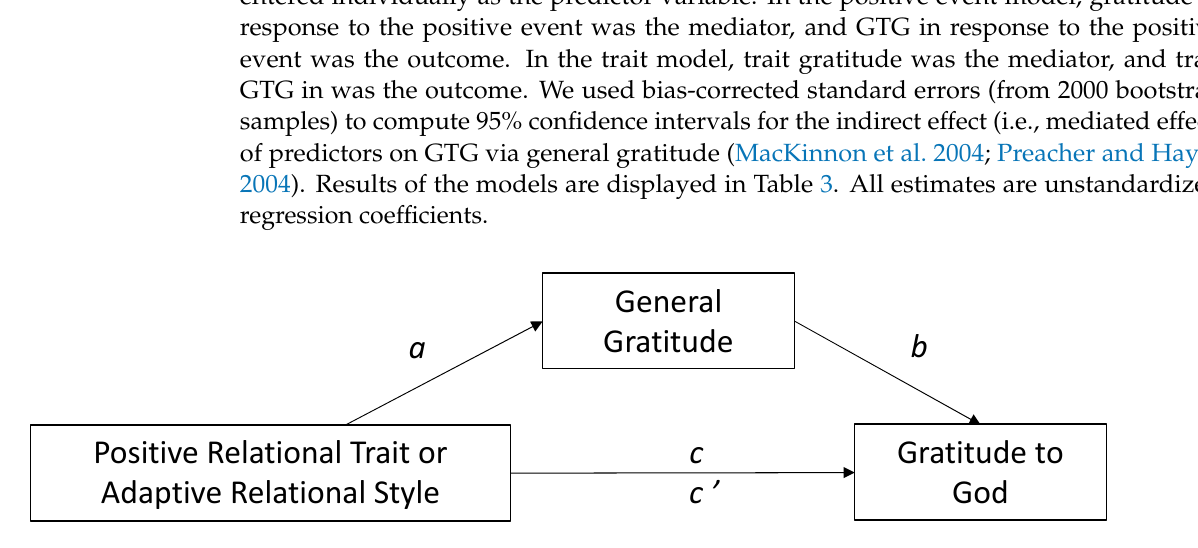
Figure 1. Conceptual Mediation Model. Note. “ a ” and “ b ” are direct effects. “ c ” is the total effect of a predictor on gratitude to God, and “ c ’” is the effect of the predictor on gratitude to God after accounting for general gratitude. In the positive event model, gratitude in response to the positive event was the mediator, and GTG in response to the positive event was the outcome. In the trait model, trait gratitude was the mediator, and trait GTG in was the outcome. Table 3. Results from Mediation Models in Which Positive Emotional Traits and Adaptive Relational Styles Predicted GTG Variables Via General Gratitude.